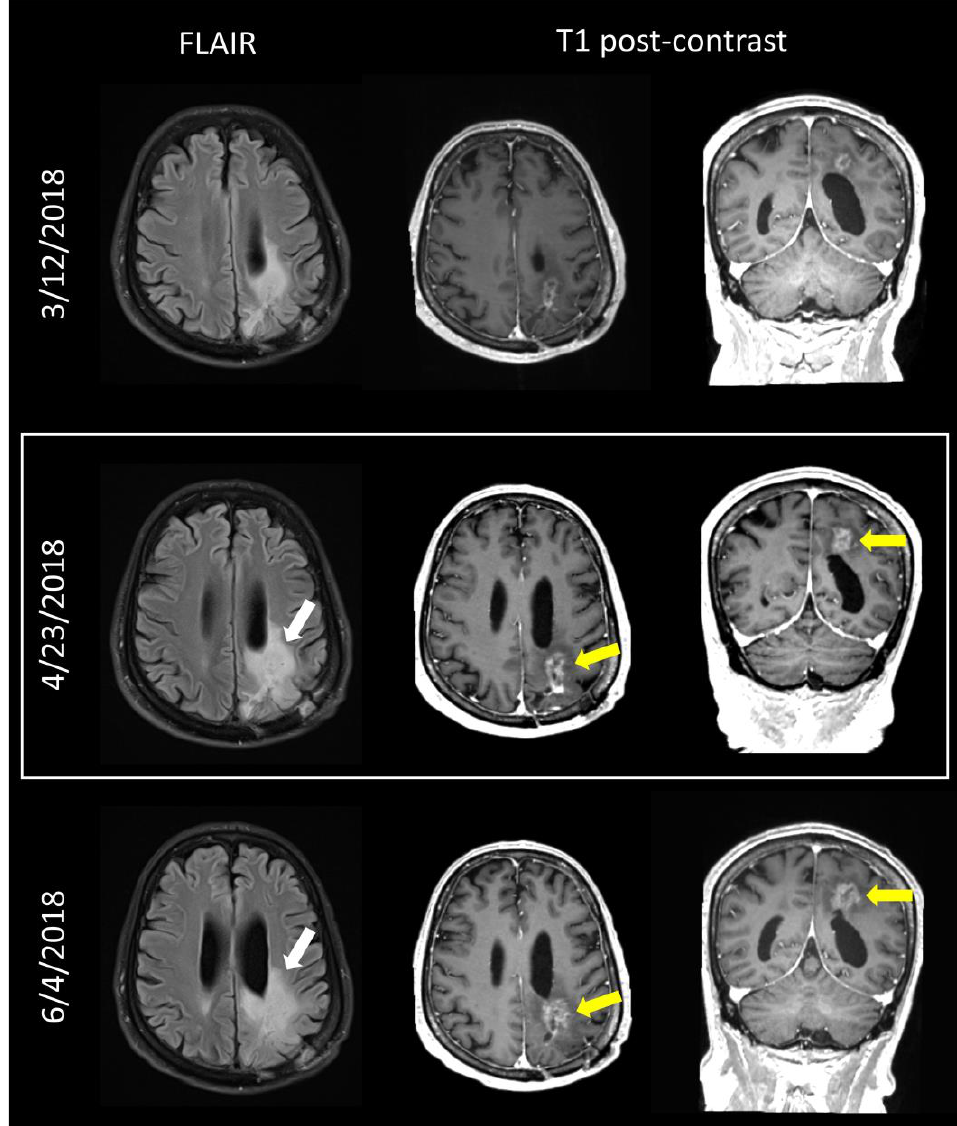
Figure 4. Images from a 71 year-old man with IDH wild-type glioblastoma. Images from 4/23/2018 (middle row, white box) were reviewed at tumor board. Compared with prior study (top row), both FLAIR (white arrow) and enhancing tumor volume were increasing (yellow arrows). While the radiology report called this study a 3b, the tumor board presenter and the tumor board consensus felt the increase was sufficient to score it as disease progression (BT-RADS 4). Subsequent follow-up (bottom row) showed further increase (arrows) and the patient underwent re-irradiation of recurrent disease.